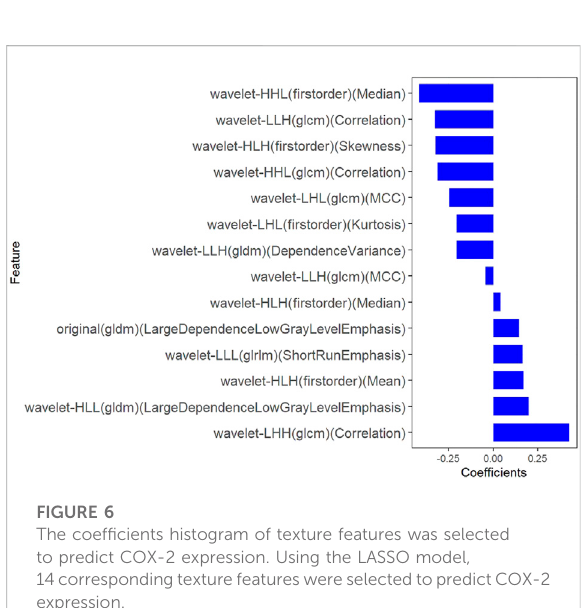
FIGURE 6 The coef fi cients histogram of texture features was selected to predict COX-2 expression. Using the LASSO model, 14correspondingtexturefeatureswereselectedtopredictCOX-2